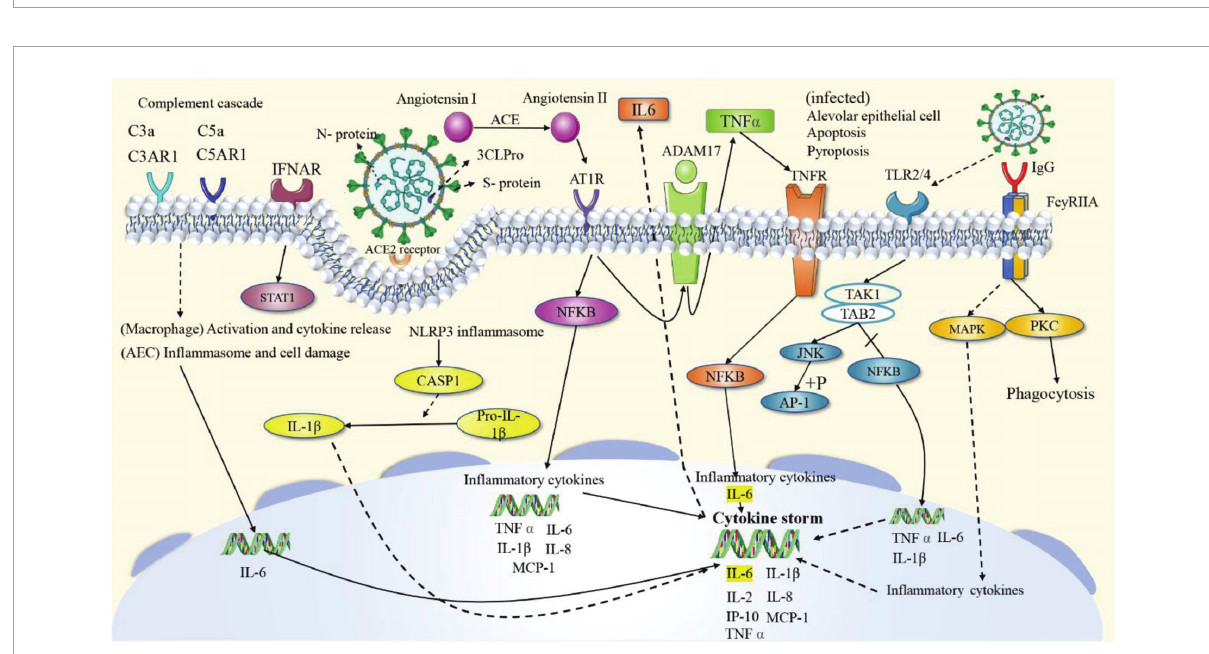
FIGURE12 The specific mechanisms of action of the four CPMs on the Coronavirus disease—COVID-19 pathway. The solid arrows represent activation, the dashed arrows represent indirect effects, and the vertical lines above the arrows represent